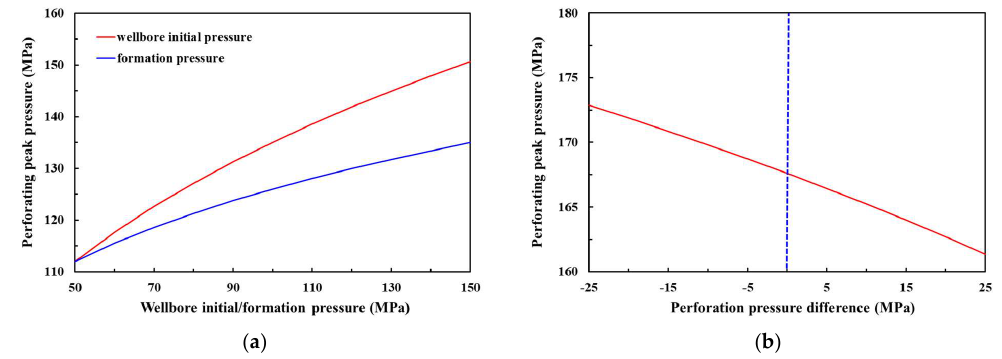
Figure 10. Formula analysis: ( a ) Influence of wellbore initial and formation pressure on perforating pressure; ( b ) Influence of perforation pressure difference on perforating pressure.